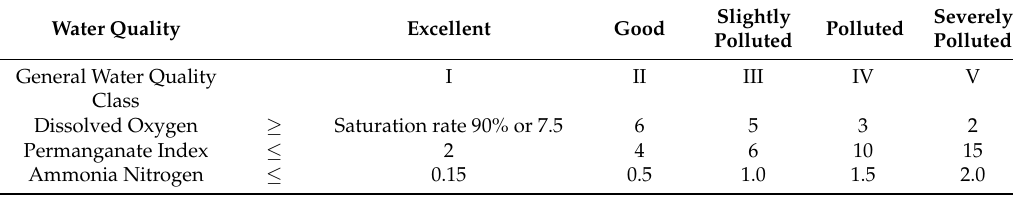
Table 1. China Environmental quality standards for ground water